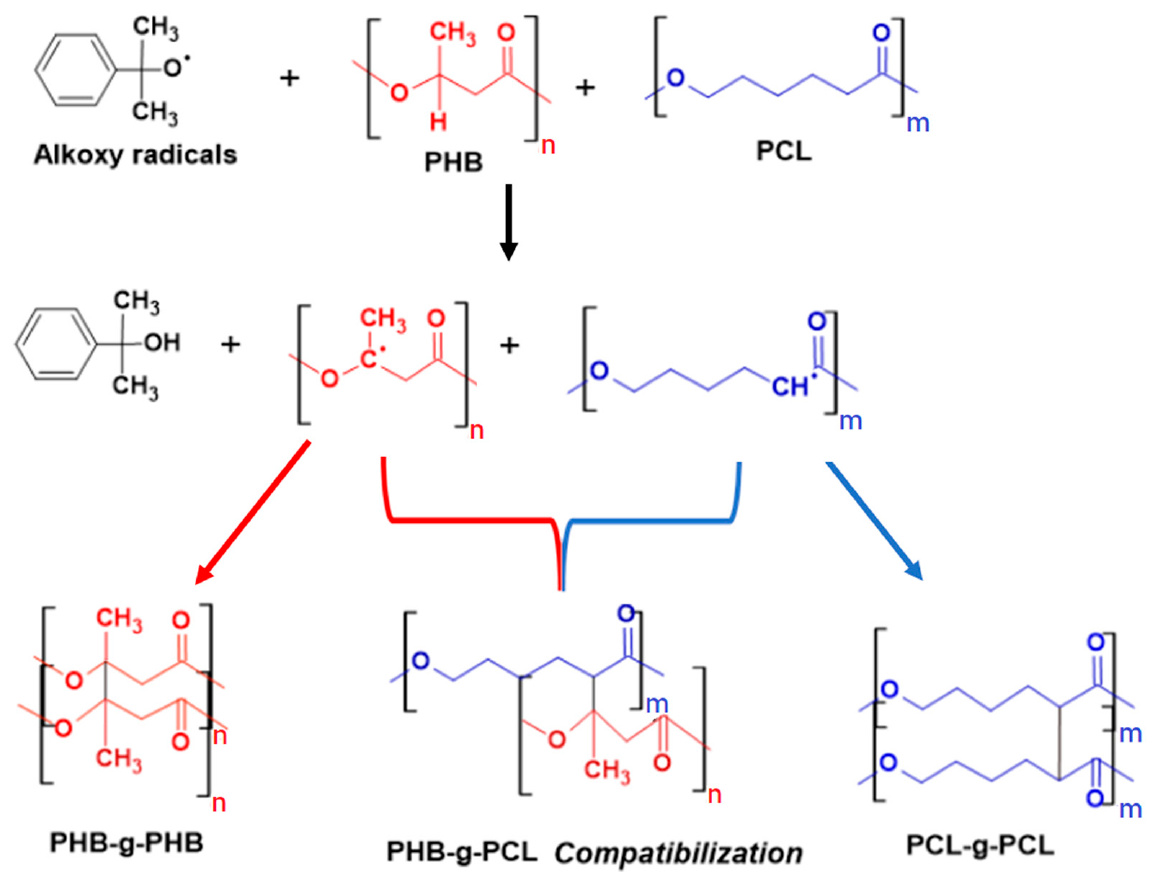
Figure 4. Schematic presentation of the possible grafting and (micro)crosslinking reactions occur- ring during the reactive melt process of PHB/PCL blends in presence of DCP.